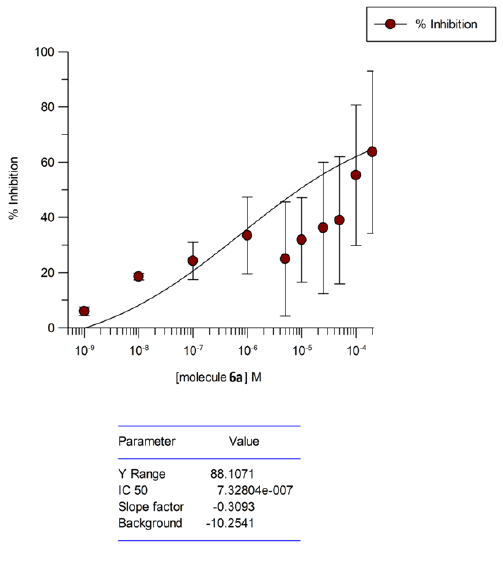
Figure 4. Alpha glucosidase inhibitory activity of compound